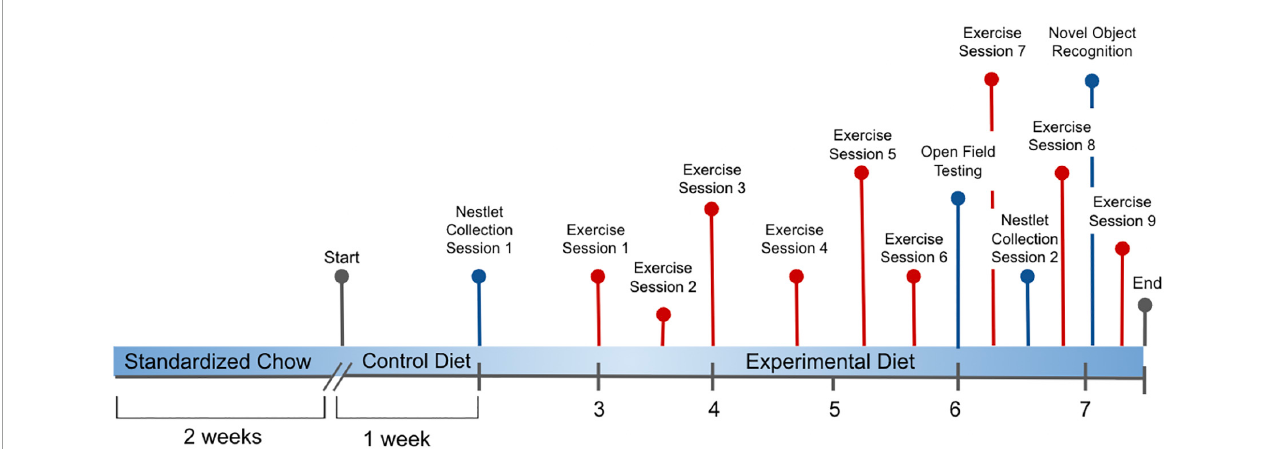
FIGURE1 Experimental process initiated with all C57BL/6J male mice provided ad libitum to a standardized Chow diet (Teklad, Envigo #8604, 24.3% protein) for 2 weeks, followed by provision of the Folic Acid (FA) Protein (P) Control diet [Harlan Custom Research Diet (TD 15201), FPC, 2 mg/kg folic acid, 17.9% protein] for 1 week. From weeks 2 to 8, mice were distributed across these 5 experimental diets: (1) 0 mg/kg folic acid FA/17.9% protein, TD.150200, FA Deficient (D) Diet (FAD; n = 16); (2) 2 mg/kg FA/17.9% protein; TD.150201, Control (C) FA Protein (P) Diet (FPC; n = 12); (3) 7 mg/kg, FA/17.9% protein; TD.15202, FA Supplemented (S) Diet (FAS, n = 16); (4) 2 mg/kg FA, 6% protein [Low Protein Diet (LPD, n = 16)]; and (5) 2 mg/kg FA/48% protein [High Protein Diet (HPD, n = 16)]. Nestlet collection occurred at weeks 1 and 6.5. Open Field Testing was assessed at week 6, and Novel Object Recognition was evaluated during week 8. Voluntary Wheel Running of the mice measured exercise during 9 sessions over 5